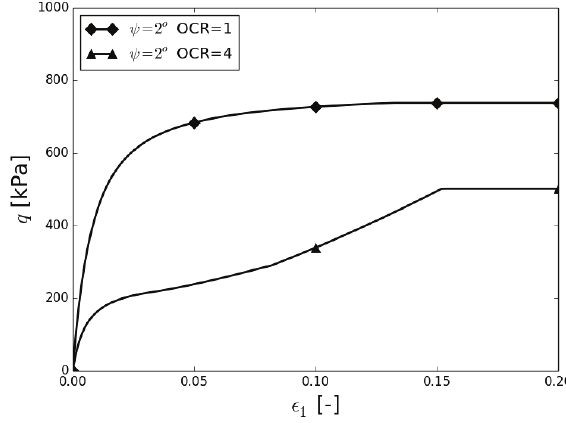
UKFig. 3. Effective stress paths for different values of OCR (OCR = 1, 4, 10, 40)